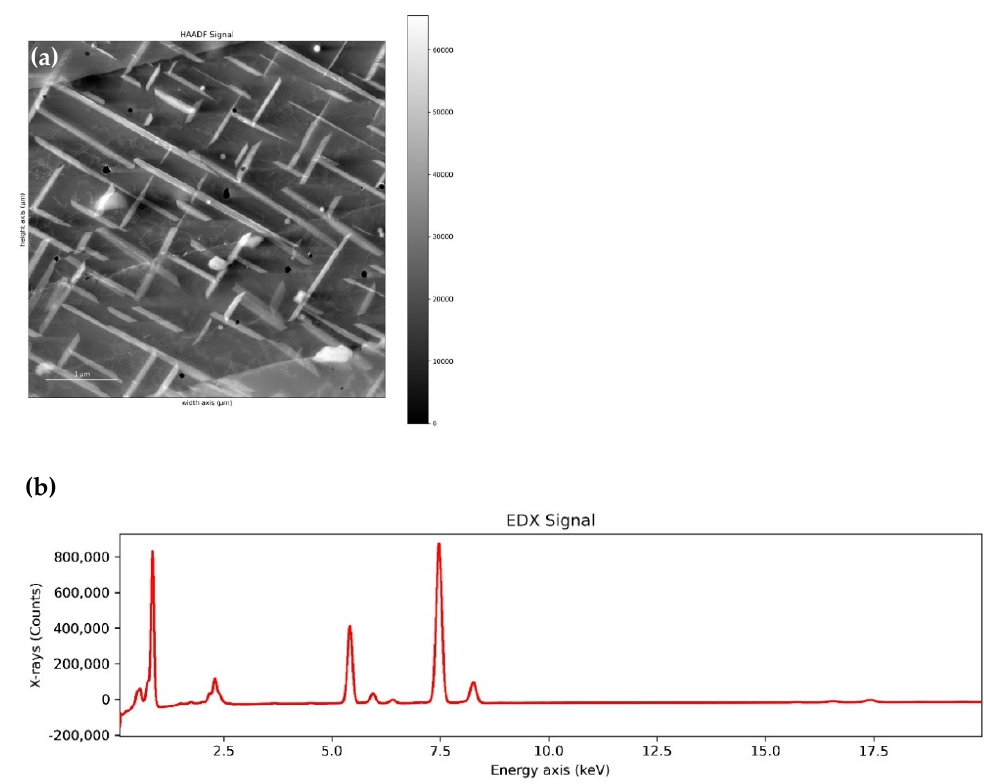
Figure 7. STEM-HAADF image of a microstructure of the L-PBF Inconel 625 post-build annealed at a temperature of 800 ° C for 500 h ( a ), and EDS sum spectrum with removed background ( b ). Three-dimensional results of EDS are flattened with summing in ranges connected to particular peaks, transforming a 1024 × 1024 × 4096 matrix to a 1024 × 1024 × 14 one.